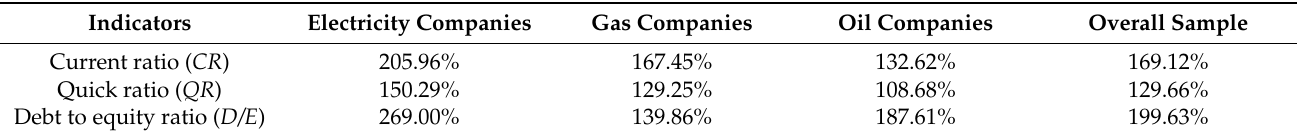
Table 5. Average values for the overall sample and each energy sector.